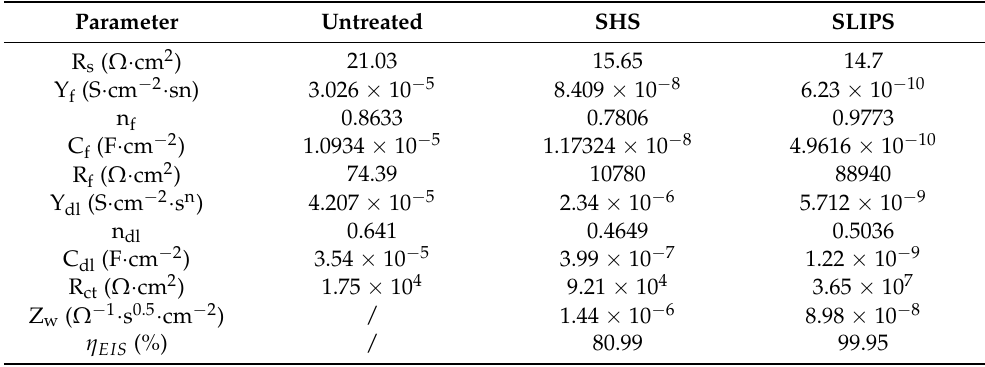
Table 2. Electrochemical parameters obtained from EIS simulation with equivalent circuit after immersion in simulated seawater for 1 h.